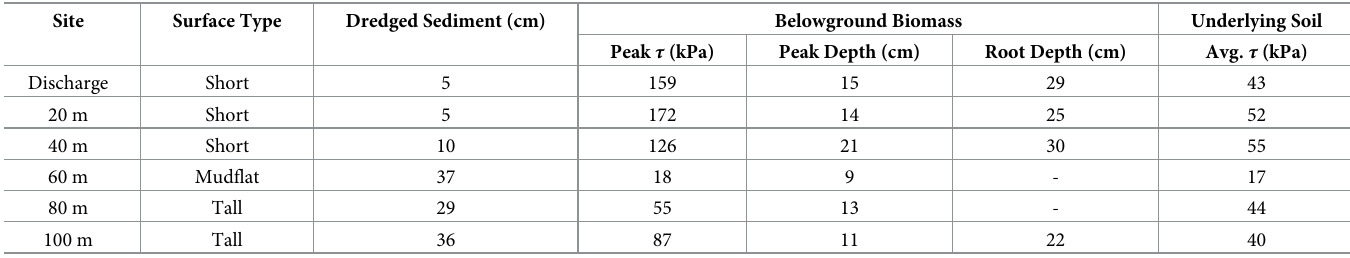
Table 1. Site description and belowground characteristics along Transect A.